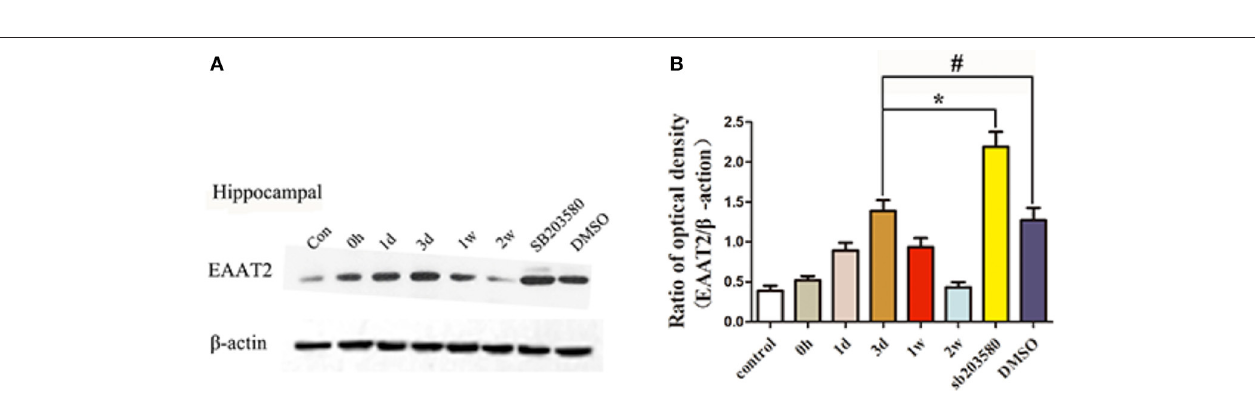
FIGURE 4 | Hippocampal EAAT2 expression in the different groups measured by Western blotting. Panel (A) shows the Western blotting image of hippocampal expression in the different groups, and (B) shows the quantification of the data in the image shown in (A) . * P < 0.05 for the comparison of the SB203580 group with the 3-d group; # P > 0.05 for the comparison of the DMSO group with the 3-d group.